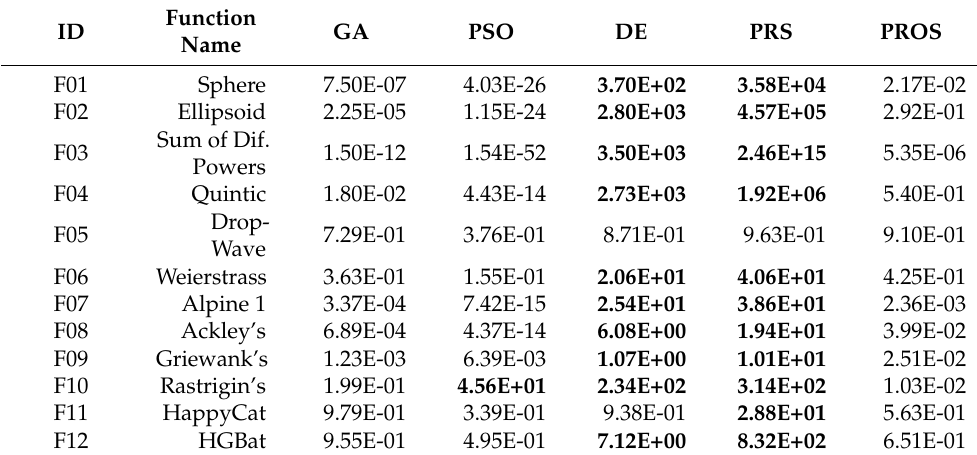
Table 7. Best results * for all 5 optimizers and all 12 objective functions, for 30 dimensions ( D = 30, averages of 10 runs). The target (optimum) value is zero in all cases